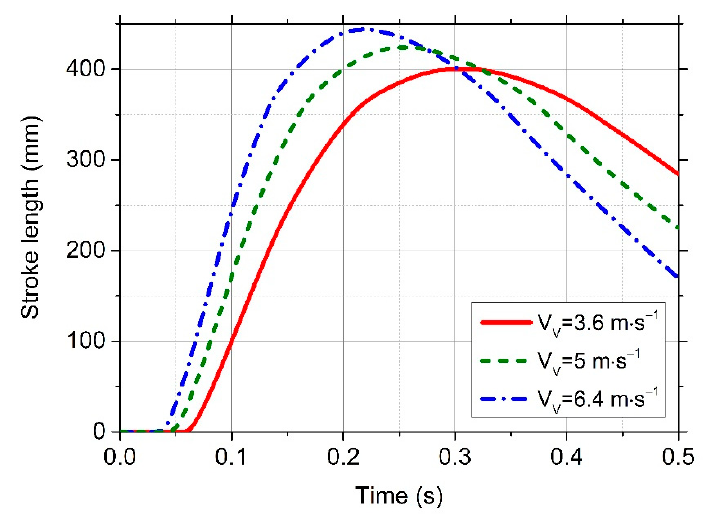
Figure 12. Changes of stroke length of main landing gear at different sinking velocity.